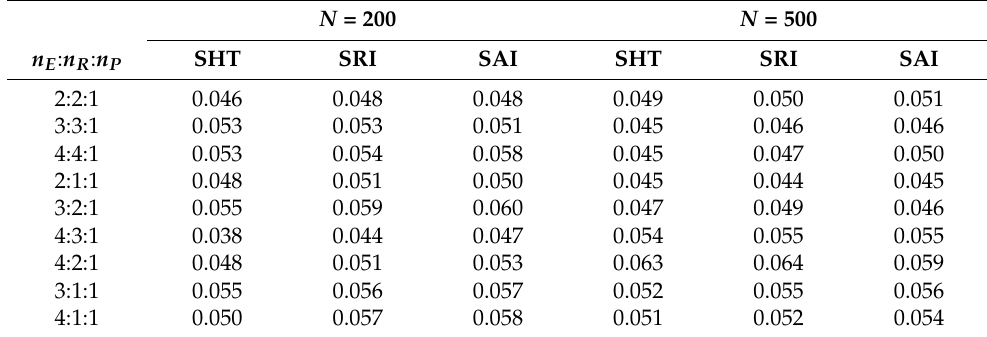
Table 2. Empirical type I error rates for unbalanced designs in the first simulation study. N =